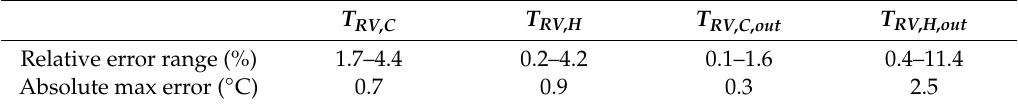
Table 3. Absolute and relative error of the thermal model.